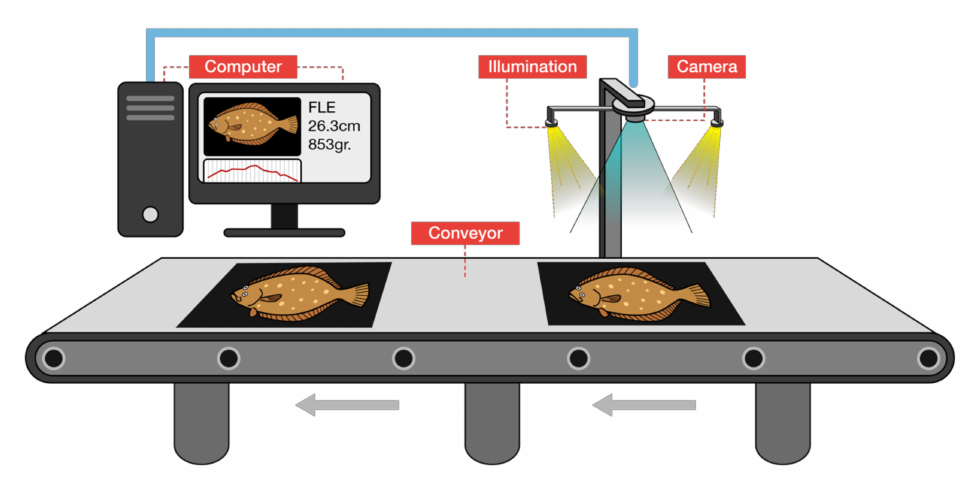
Figure 9. Schematic diagram of the CatchMeter